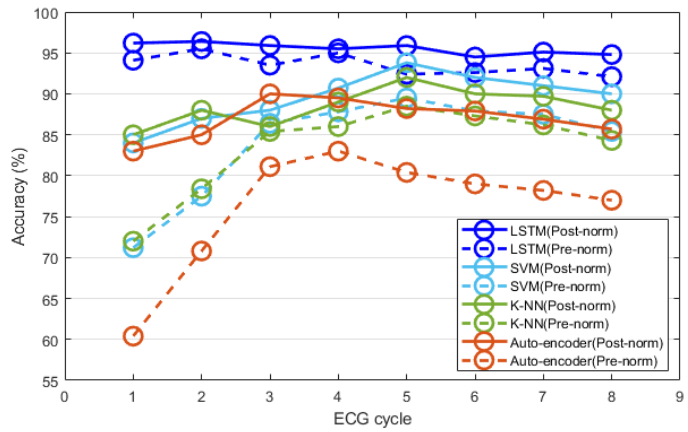
Figure 10. Comparative analysis of user recognition performance before and after time normalization, in terms of the number of ECG cycles.